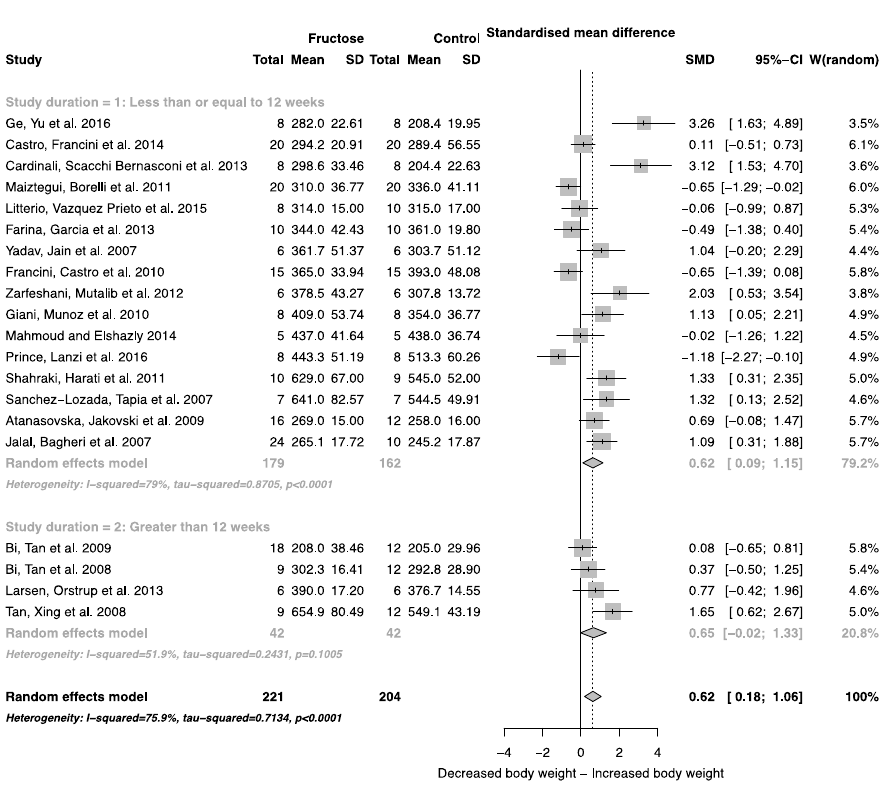
Less Than or Equal to Greater Than 12 Weeks ( n = 20)